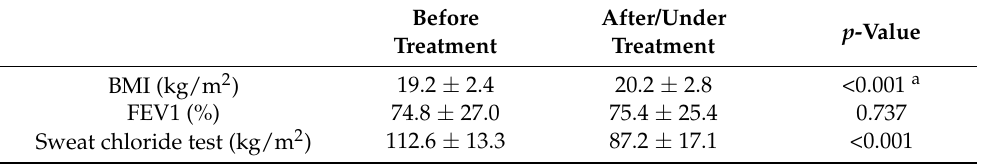
Table 3. Evolution before–after treatment of BMI, FEV1, and sweat test in pediatric population.